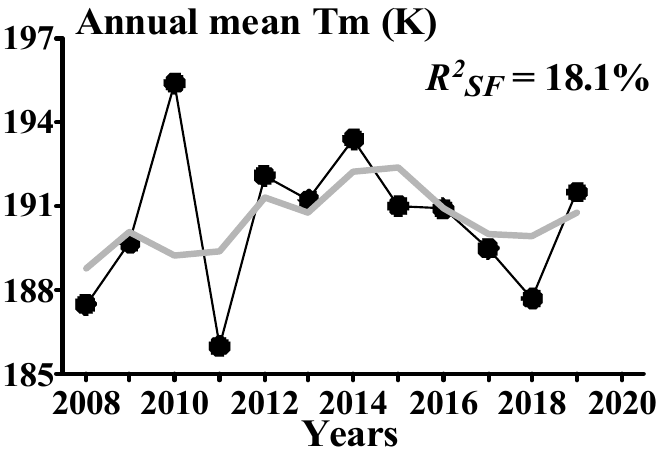
Figure 8. Year-to-year variations in the annual mean Tm (black circle line) and their approximation by the multiple regression on SOI and F10.7.